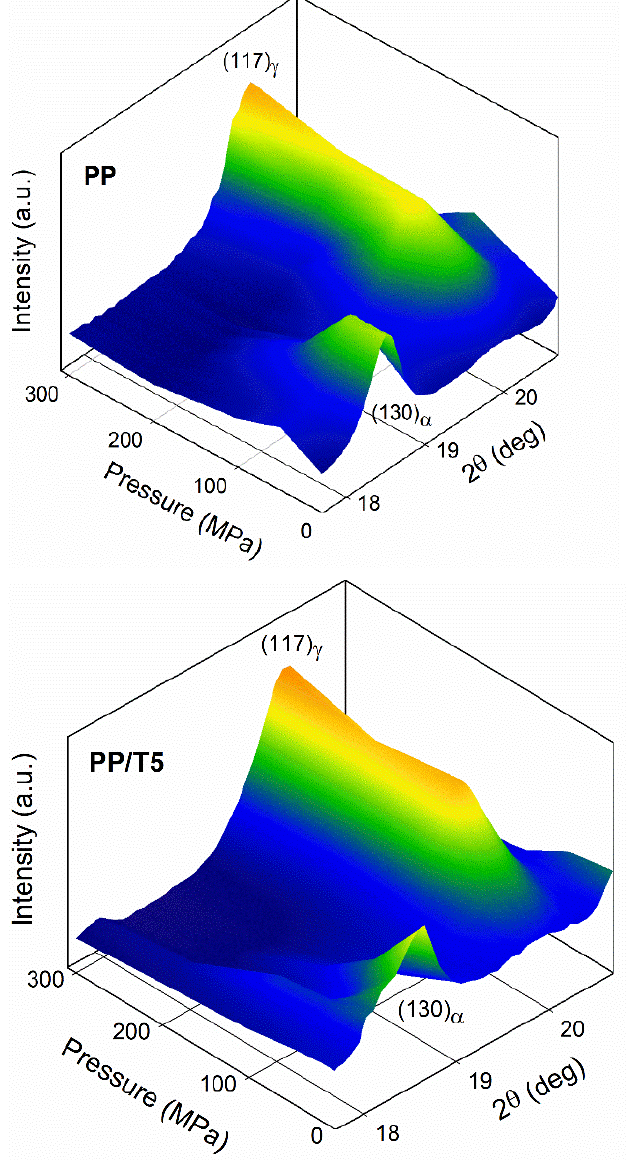
Figure 6. (130) α and (117) γ peaks in WAXD diffractograms of PP and PP/T5 crystallized during cooling under various